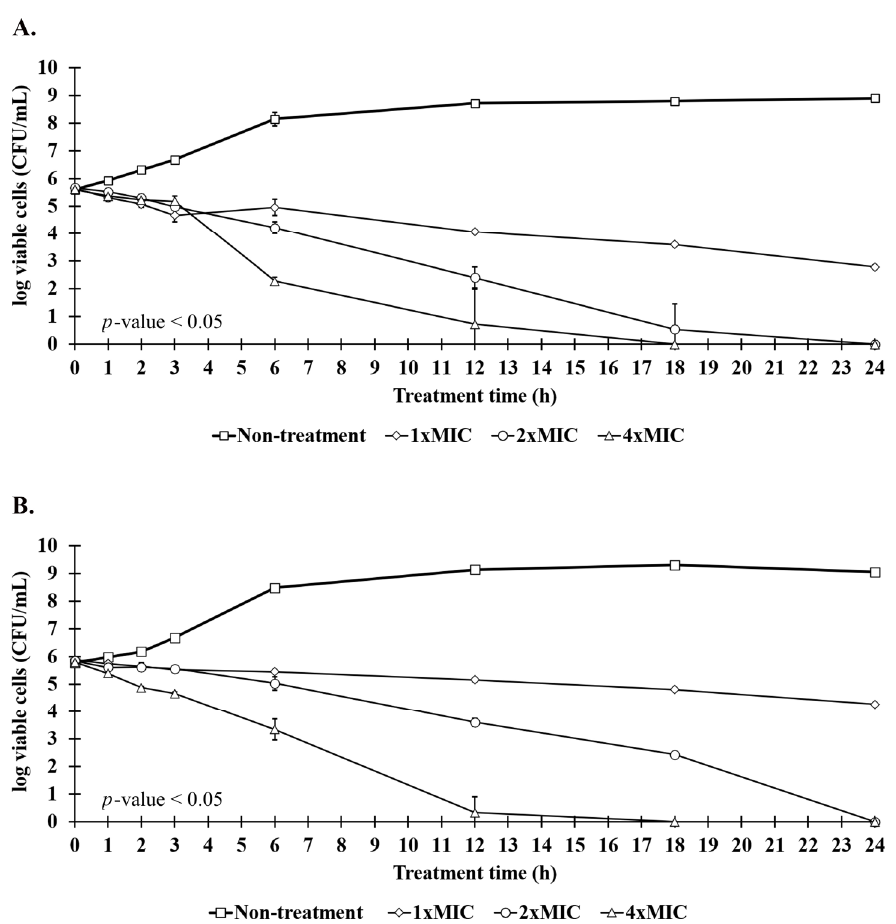
Figure 7. Killing kinetics of anti-MRSA peptide (P1). ( A ) S. aureus TISTR 517 and ( B ) MRSA isolate 2468 were incubated with 1× ( ◊ ), 2× ( ○ ), and 4× MIC (Δ) of P1 and compared to the non-treatment condition (□). The viable cells were counted by spreading an aliquot of samples on MH agar, and the result was expressed as a log of the viable cell count (CFU/mL). Significant differences ( p -value < 0.05) were analyzed by two-way ANOVA comparing treated and non-treated samples.